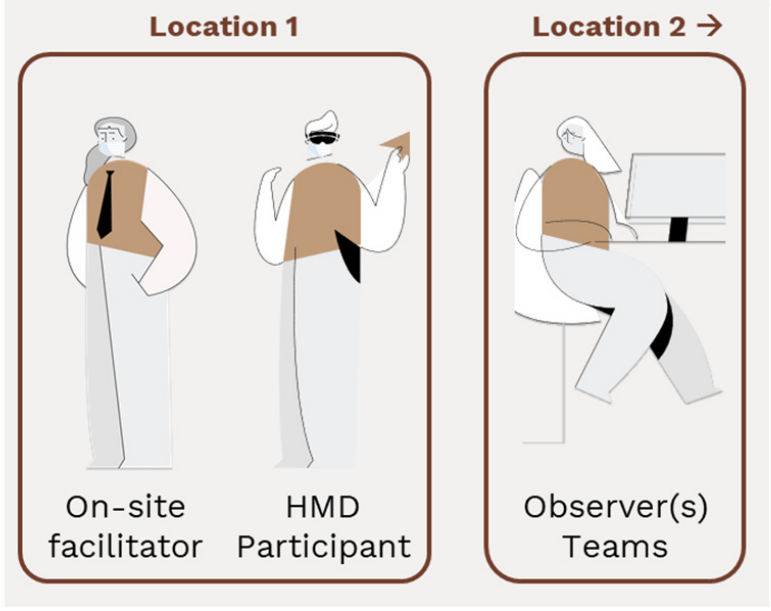
Figure 7. Test setup used in Case 3.